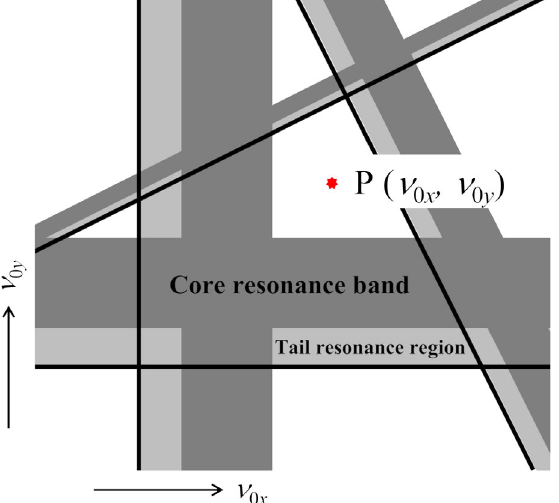
FIG. 18. Determination of a machine operating point on the basis of the coherent concept. The shaded areas represent the coherent core resonance bands whose central positions are predicted by Eq. (8). The width of each instability band generally depends on the resonance strength. We have a possibility of non- negligible emittance growth also in the areas of a lighter shade where quasi-single-particle resonances can be excited in the beam tail. The horizontal and vertical tail resonance regions adjacent to the half-integer lines may contain a narrow band of the severe dipole ( m ¼ 1 ) resonance [39]. The machine operating point P must be placed within a resonancefree